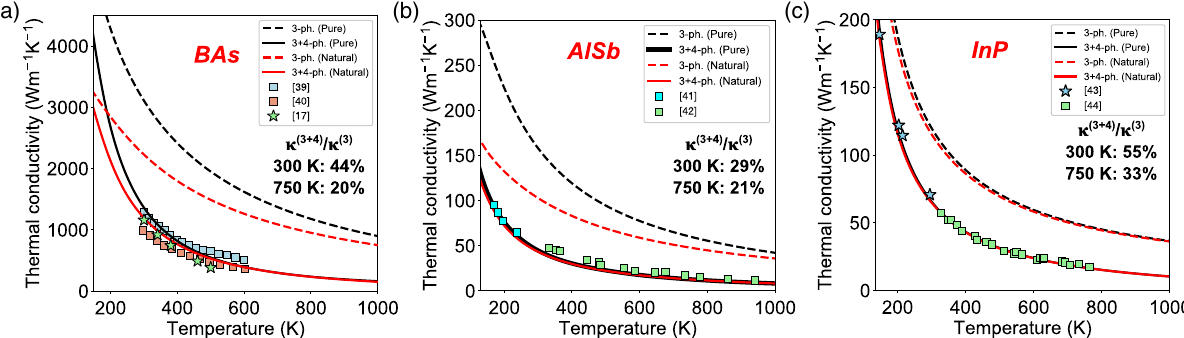
ð 3 Þ ð 3 þ 4 Þ ð 3 Þ ð 3 þ 4 Þ (dashed black line), κ (solid black line), κ (dashed red line), and κ (solid red line) Pure Pure Nat Nat